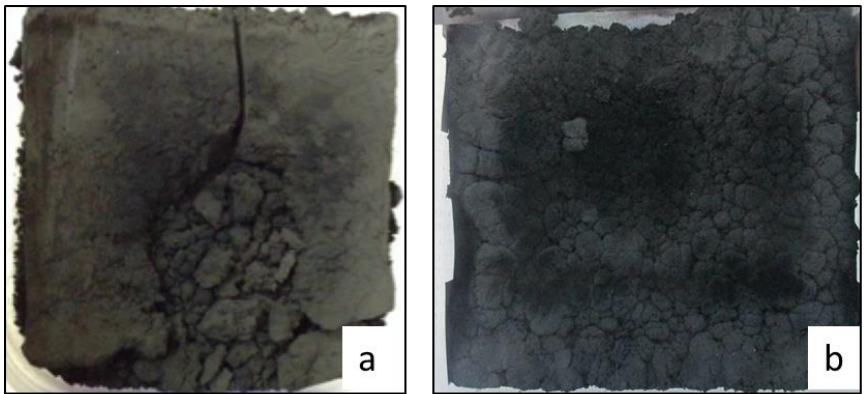
Figure 7. Comparison between product generated by the use of deflectors in Figure 2e ( a ) and 2f ( b